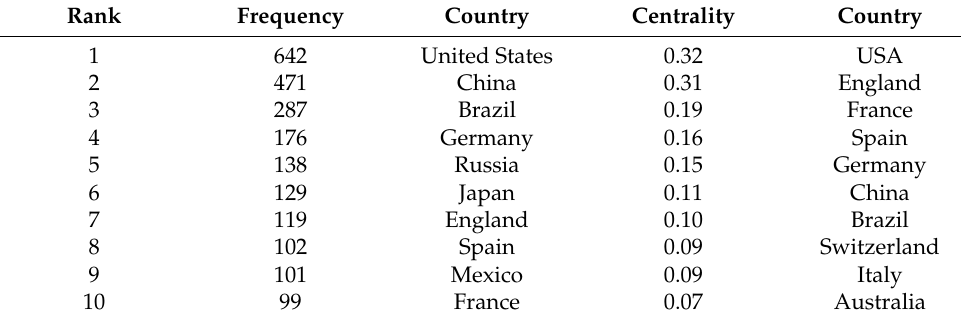
Table 5. Top 10 countries based on cited